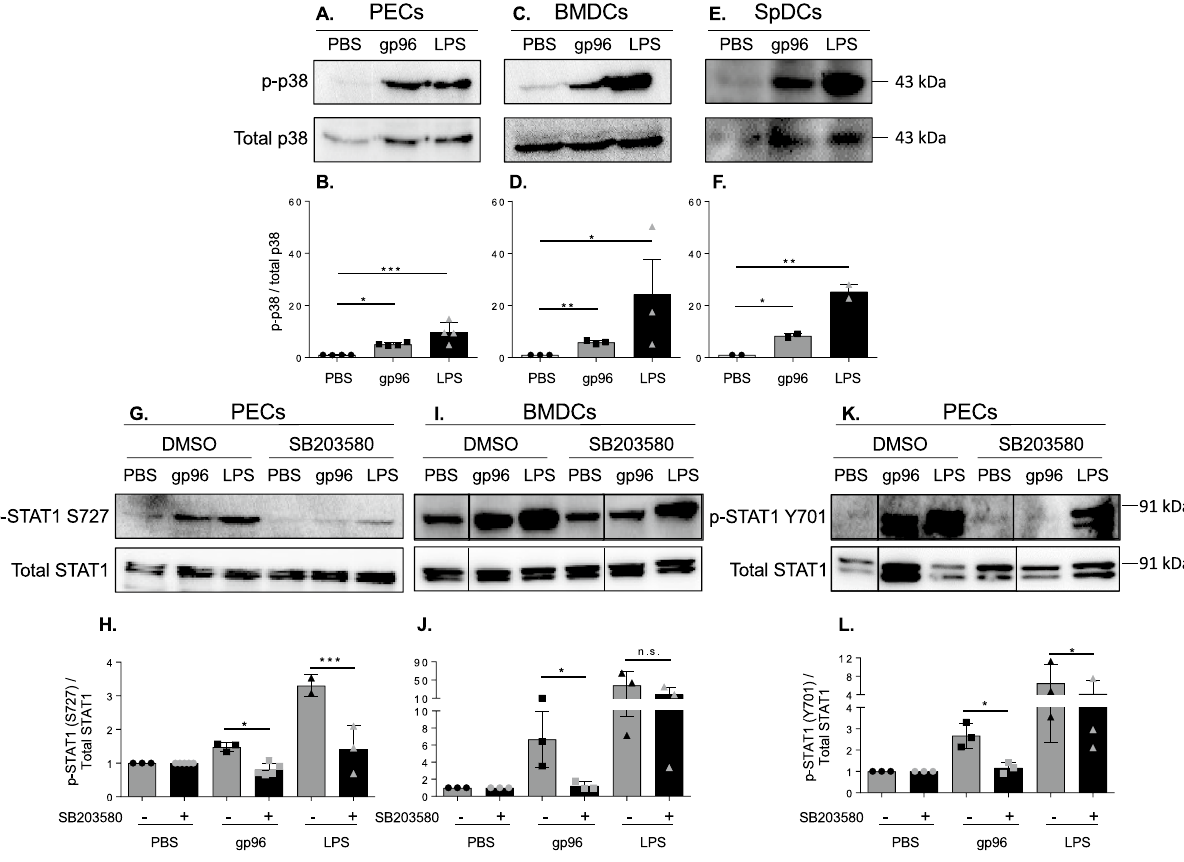
Figure 5. P38 expression does not differ among APC and is required for STAT1 phosphorylation. (A-F) PECs, BMDCs, or SpDCs were activated with 200 µ g/mL gp96 or 1 µ g LPS for 20 min. Cells lysates were immunoblotted for phospho-p38 as well as total p38. (A,C,E) Representative blots are shown. (B,D,F) Pooled data from 3 independent experiments is shown. (G-K) PECs or BMDCs were pre-treated for 2 h with SB203580 and then activated with 200 µ g/mL gp96 or 1 µ g LPS for (G-H) 20 min or (I-L) 120 min. Cells lysates were immunoblotted for phospho-STAT1 (G-J) S727 or (K-L) Y701 as well as total STAT1. Immunoblot data (A,C,E,G,I,K) shown represents one of at least 3 independent experiments. Data in the graphs (B,D,F,HJ,L) are pooled from at least 3 independent experiments. Data are represented as mean ± s.d. ns not significant, *p < 0.05, **p < 0.01, ***p < 0.001 (One-way ANOVA used in panels B,D,F; and Two-way ANOVA used in panels H,J,L; both with Sidak’s multiple comparison